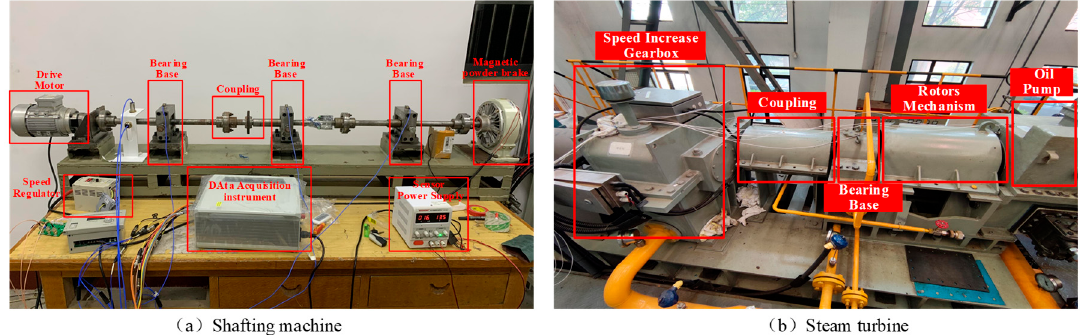
Figure 3. Test bench for RMs: ( a ) the shafting machine operated in lab environment; ( b ) the steam turbine operated in real-world